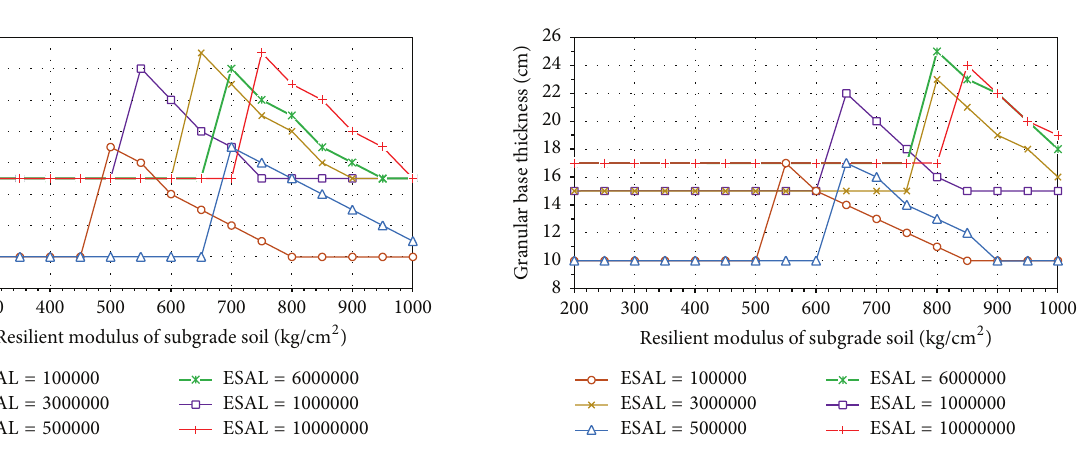
Figure 6: Optimal design thickness of granular base for major rural roads.